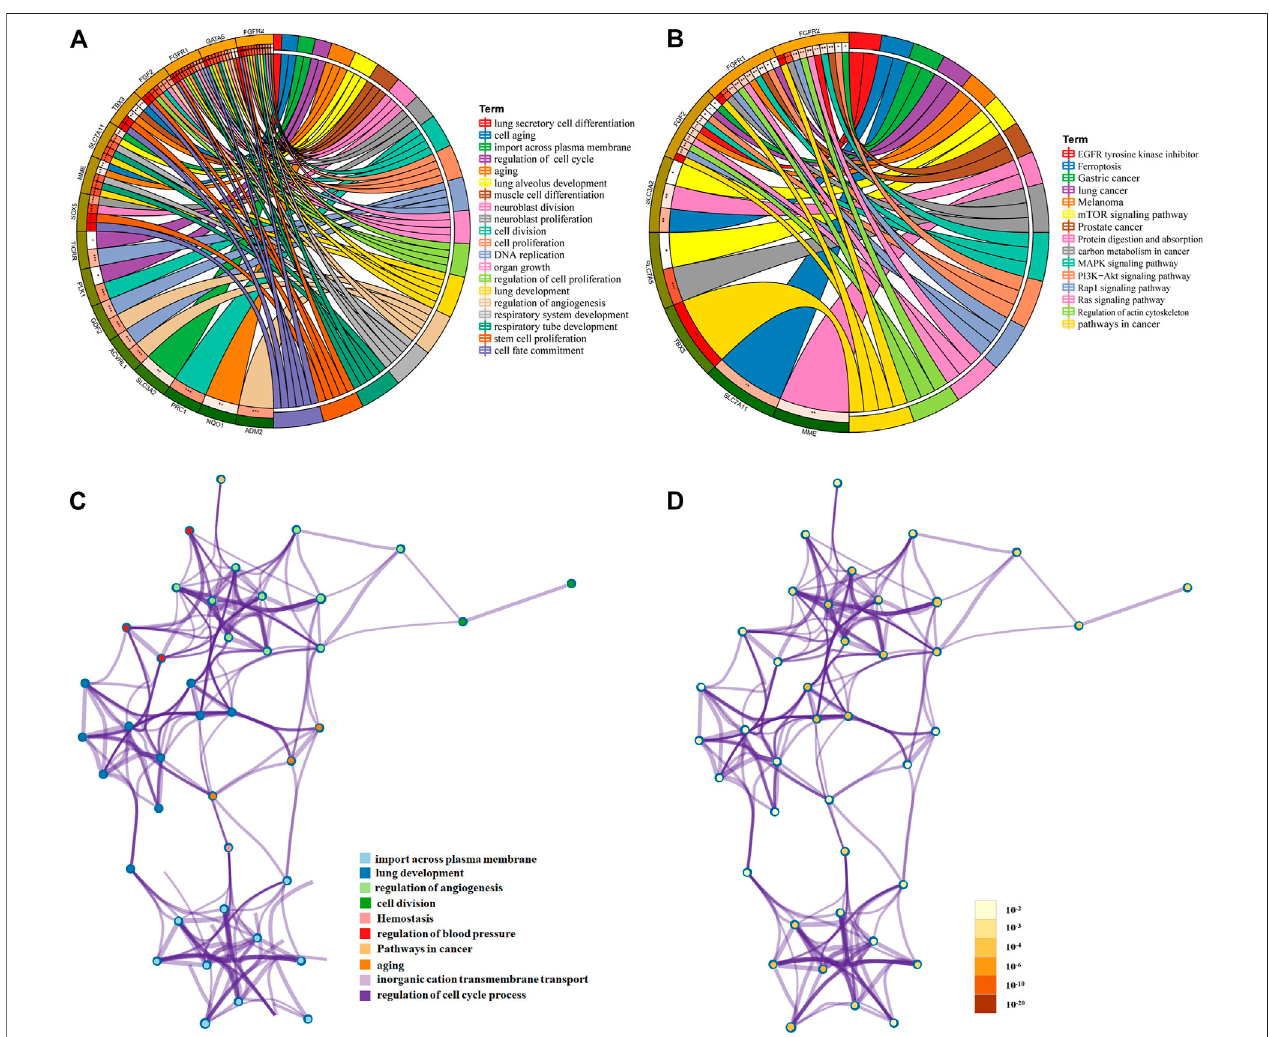
FIGURE 3 | Functional and pathway enrichment analysis of mRNAs in ceRNA. Chord diagram showing enriched (A) GO clusters and (B) KEGG clusters for the mRNAs; mRNAs are shown on the left, and enriched GO or KEGG clusters are shown on the right; (C,D) interaction network of GO- and KEGG-enriched terms using Metascape. (C) ColoredbyclusterID, wherenodesthatshare thesameclusterIDaretypicallyclosetoeachother; (D) coloredby p -value,wheretermscontainingmore genes tend to have a more signi fi cant p -value.